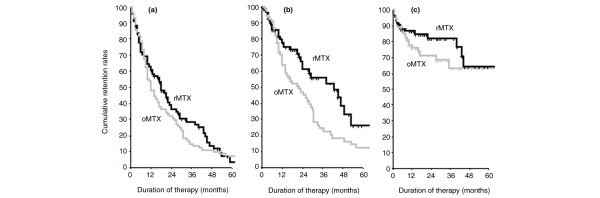
Cumulative retention rates of methotrexate therapies. Kaplan-Meier analysis of retention rates of methotrexate. The different panels show (a) the overall drug retention, (b) retention of drug effectiveness, and (c) retention of drug safety for original therapy (grey lines; oMTX) and re-employed therapy (black lines; rMTX). Overall retention rates were similar between the two groups (panel a: P = 0.31, by log-rank test). Likewise, retention because of safety was similar between groups (panel c: P = 0.23). Retention because of effectiveness was better for the rMTX group (panel b: P < 0.01).